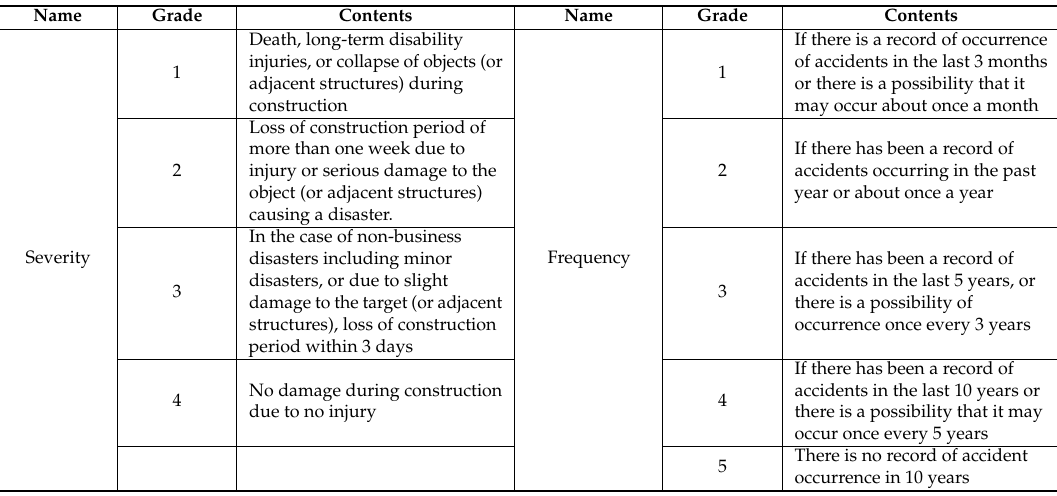
Table 1. Criteria for risk rating